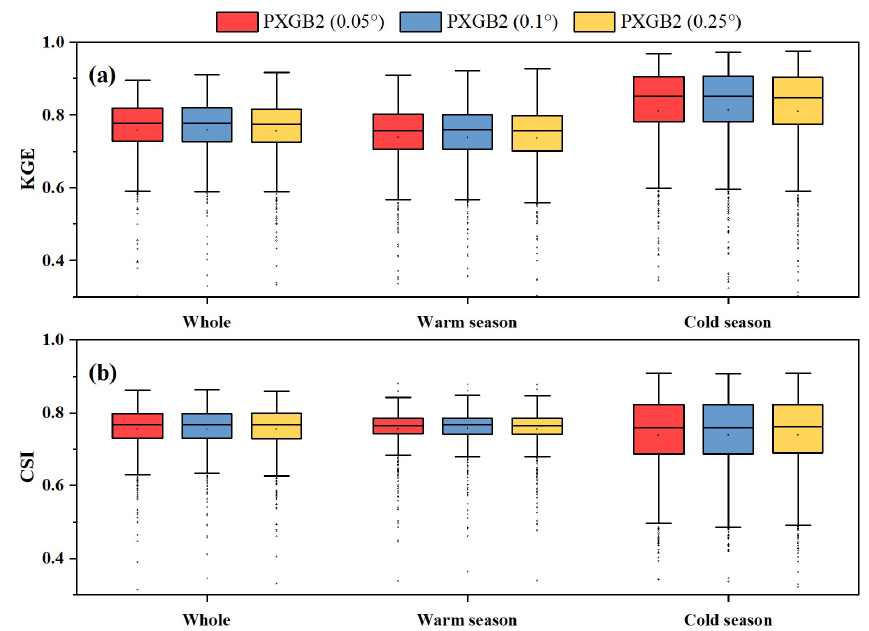
Figure 14. The performance ( (a) KGE and (b) CSI) of PXGB2 prepared by MSPs with different spatial resolutions (0.05, 0.1, and 0.25 ◦ ) during the whole period, warm season, and cold